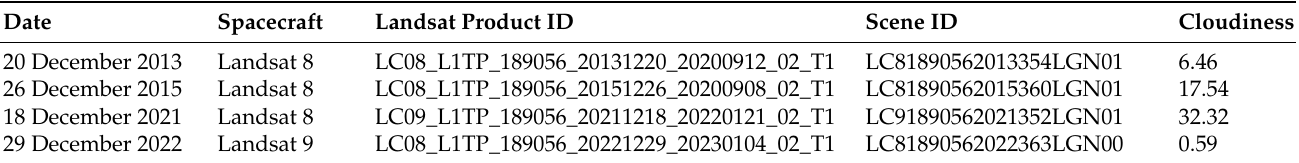
Table 1. Satellite images used for computing ten VIs: Landsat 8-9 OLI/TIRS from the USGS 1